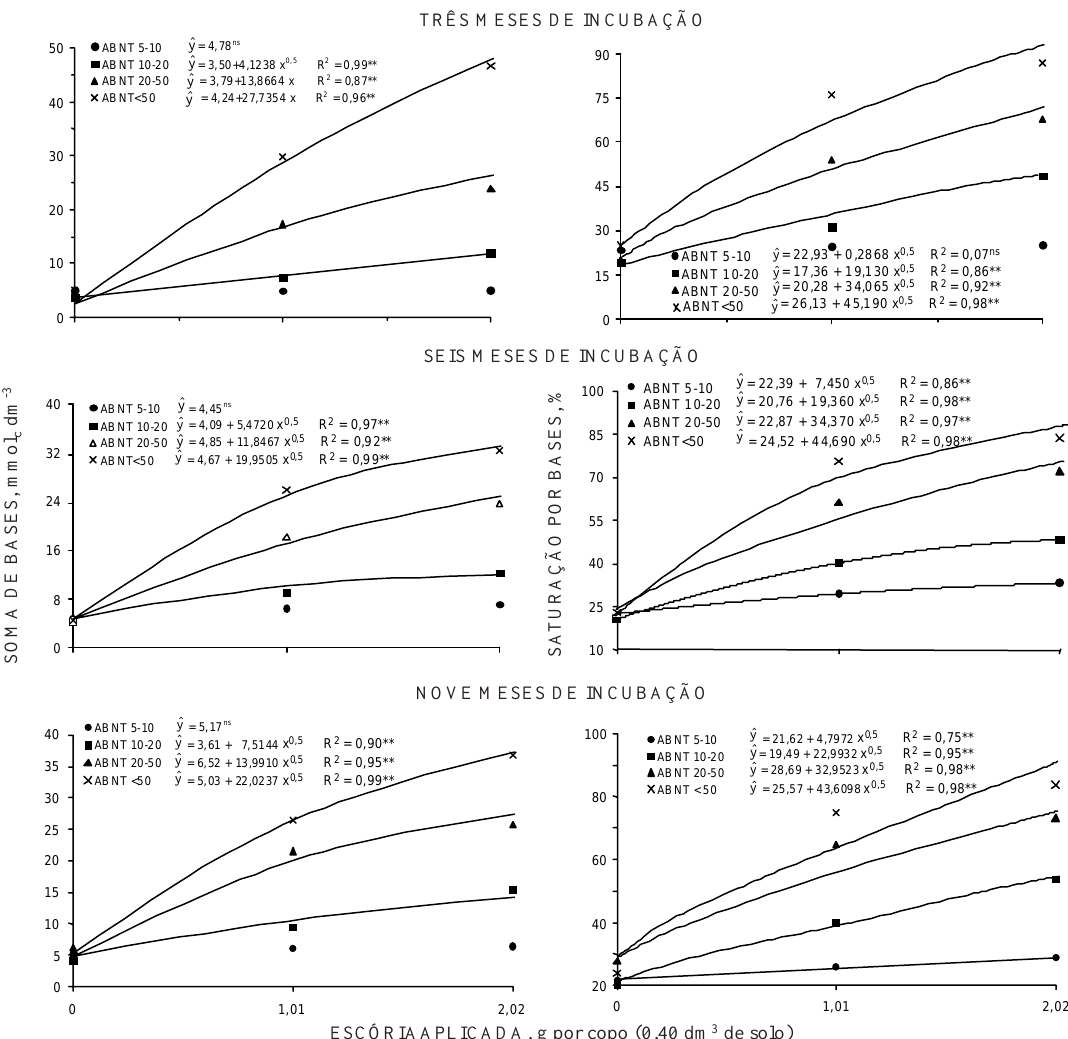
Figura 2. Frações granulométricas da escória de siderurgia na soma de bases e na saturação por bases de um Latossolo Vermelho distrófico, após três, seis e nove meses de